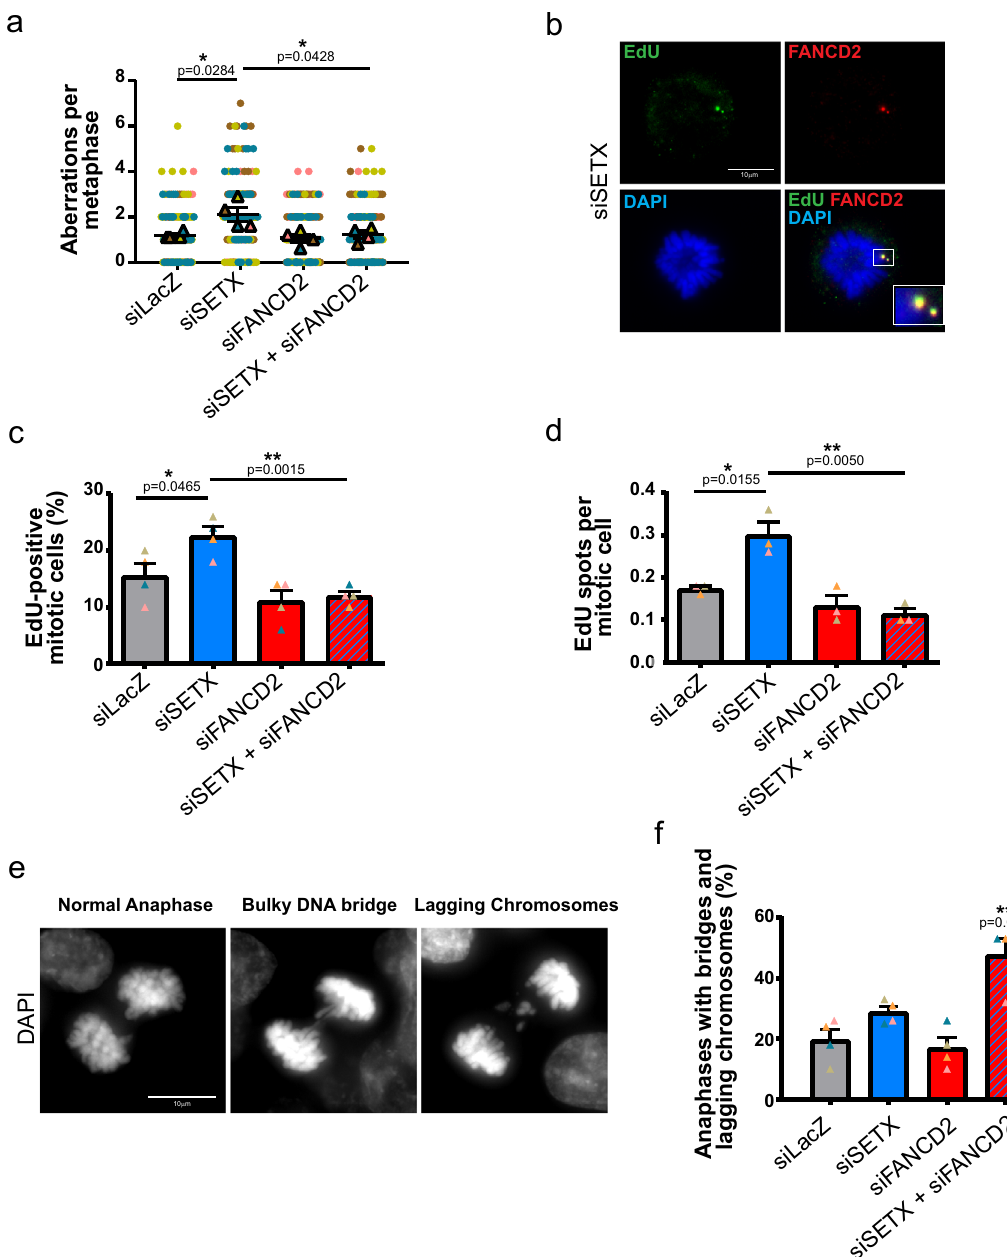
Fig. 3 FANCD2 promotes MiDAS and prevents chromosome segregation defects in SETX-depleted cells. a Quanti fi cation of chromosome aberrations in control (LacZ), SETX, FANCD2 and SETX and FANCD2 siRNA-transfected cells. b Representative metaphase from SETX-depleted condition labeled with EdU (green) and stained for FANCD2 (red) showing EdU incorporation in mitotic chromosomes colocalizing with FANCD2. DNA is counterstained with DAPI (blue). c Quanti fi cation of the percentage of metaphases showing EdU incorporation in control (LacZ), SETX, FANCD2, or SETX and FANCD2 siRNA- transfected cells. d Quanti fi cation of the number of EdU signals (spots) in mitotic cells from control, SETX, FANCD2, or SETX and FANCD2 siRNA- transfected condition. e Representative examples from immuno fl uorescence analysis of chromosome segregation at anaphase showing normal chromosome segregation, anaphase bridges, and lagging chromosomes. DNA was counterstained by DAPI to show bulky DNA bridges and lagging chromatin. f Quanti fi cation of bulky DNA bridges and lagging chromosomes from control, SETX, FANCD2, and SETX and FANCD2 siRNA-transfected